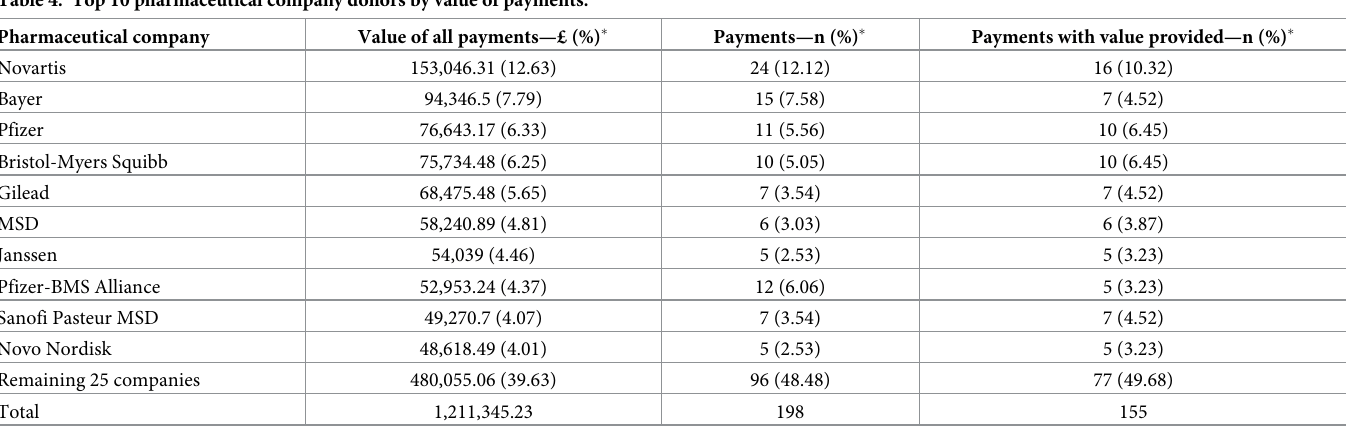
Table 4. Top 10 pharmaceutical company donors by value of